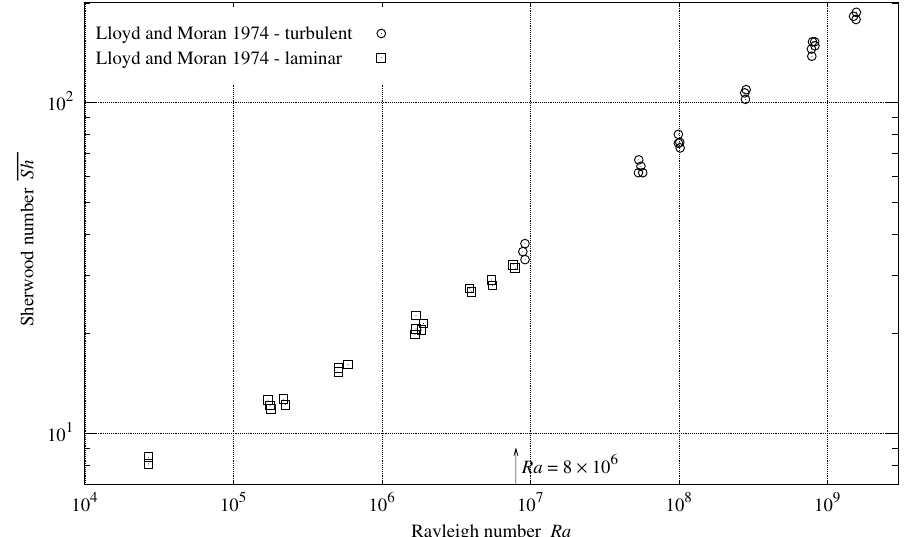
Figure 2. Upward convection mass transfer from horizontal